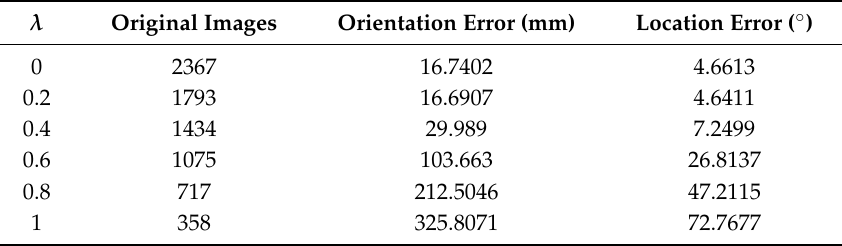
Table 5. Estimated camera location (mm) and orientation ( ◦ ) errors of Object1 in using training data with different viewpoint density controlled by λ